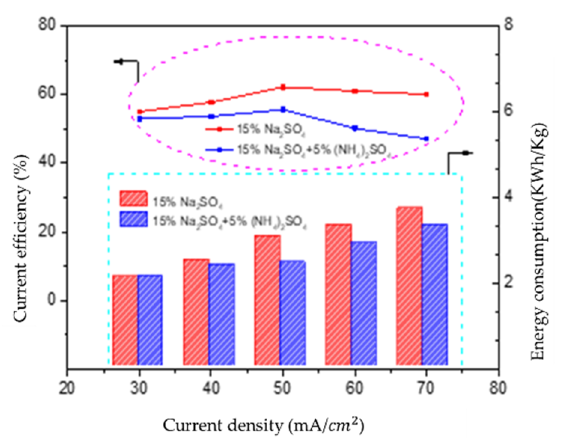
Figure 5. The change of current efficiency and energy consumption before and after adding (NH 4 ) 2 SO 4 with different current densities.